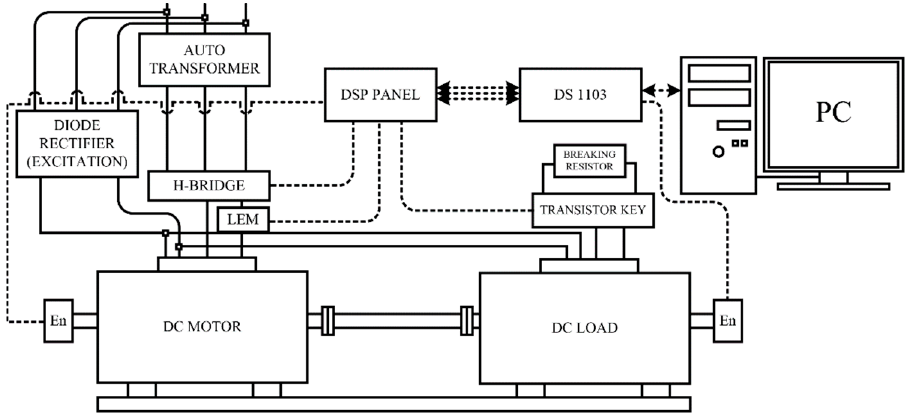
Figure 29. Block diagram of the experimental system.